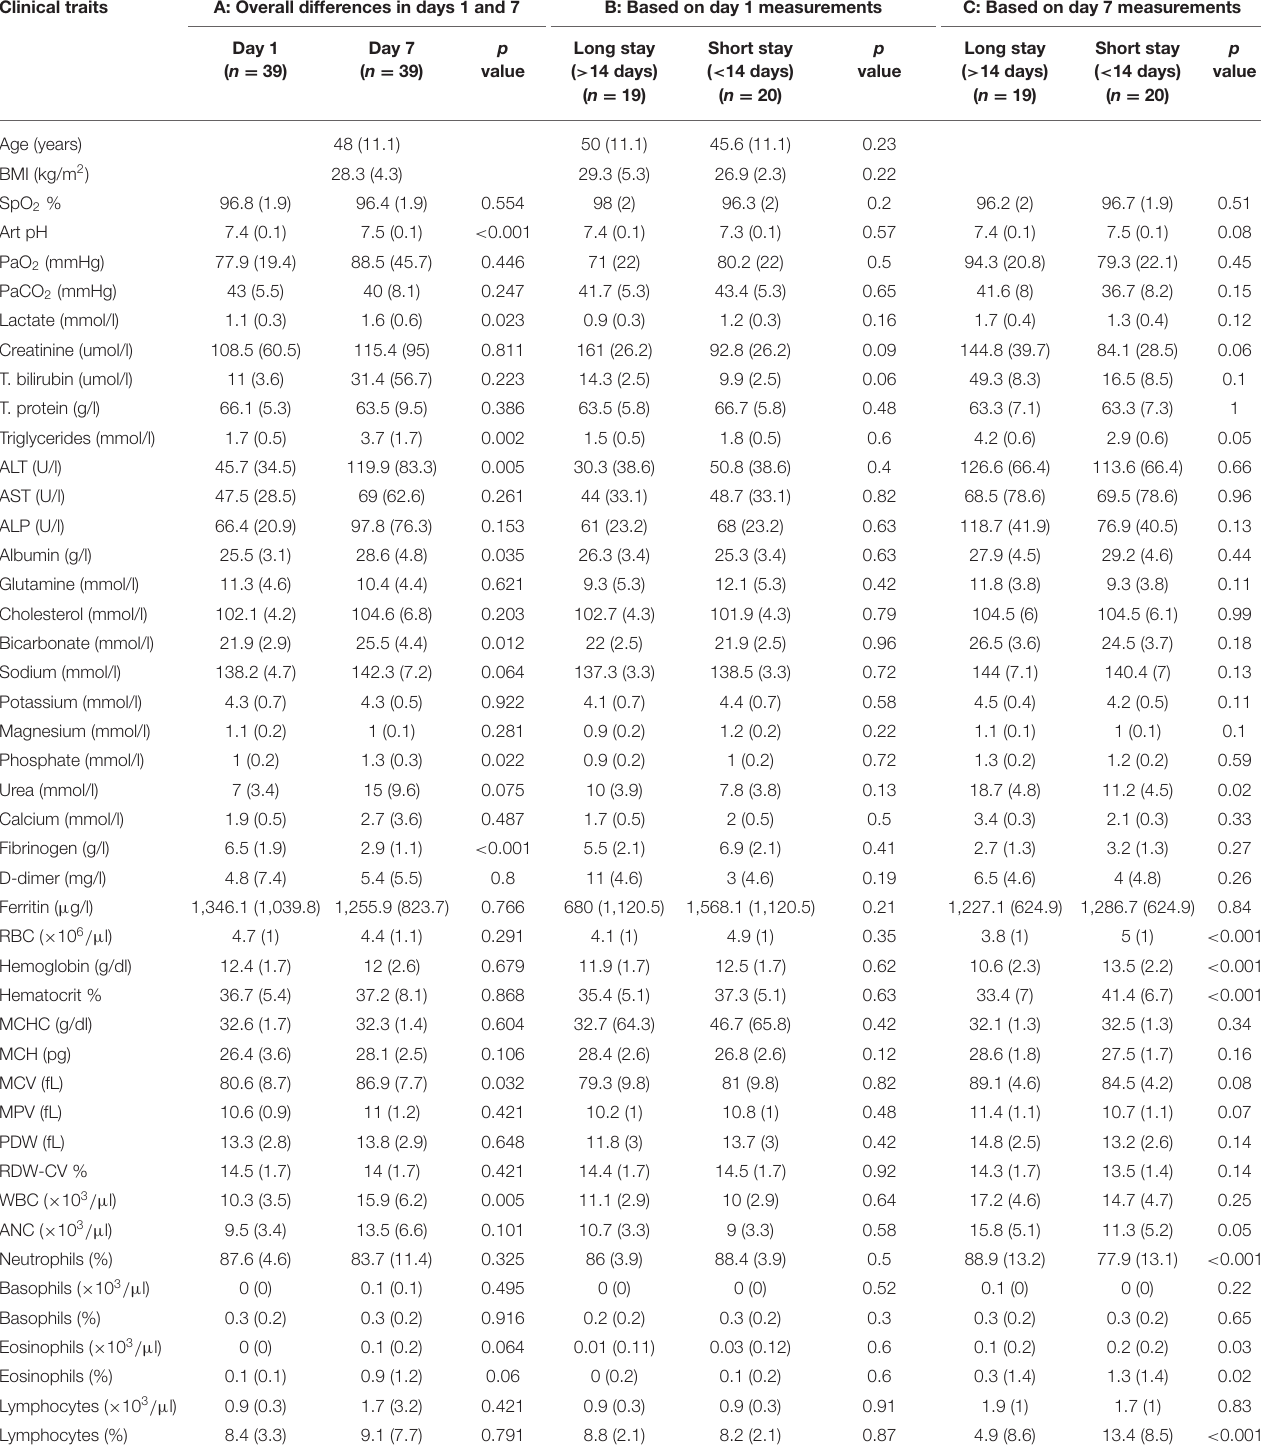
TABLE 1 | Clinical features of critically-ill COVID-19 patients. Clinical